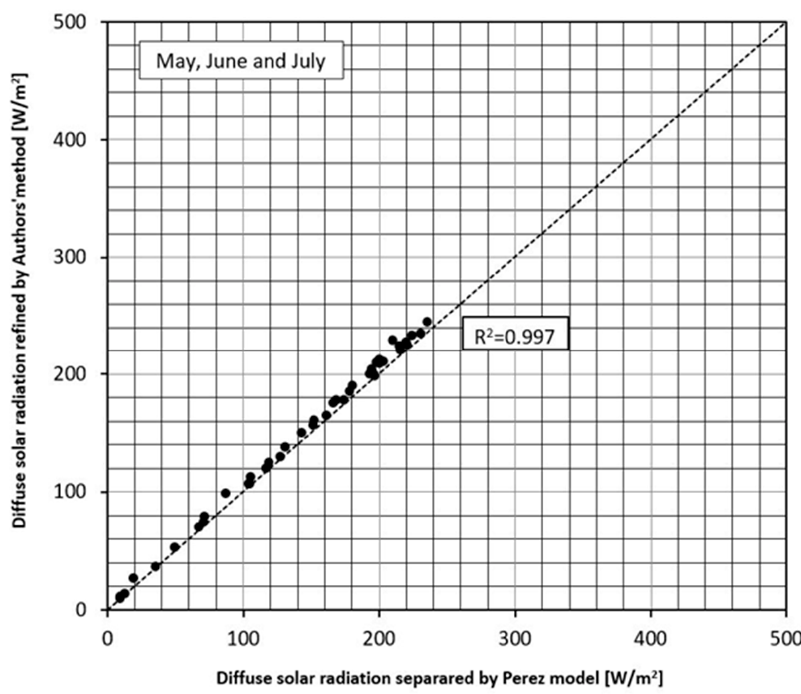
Figure 11. Correlation of diffuse solar radiation between the Perez model and the authors’ proposed simple refinement method in three months (from May to July).